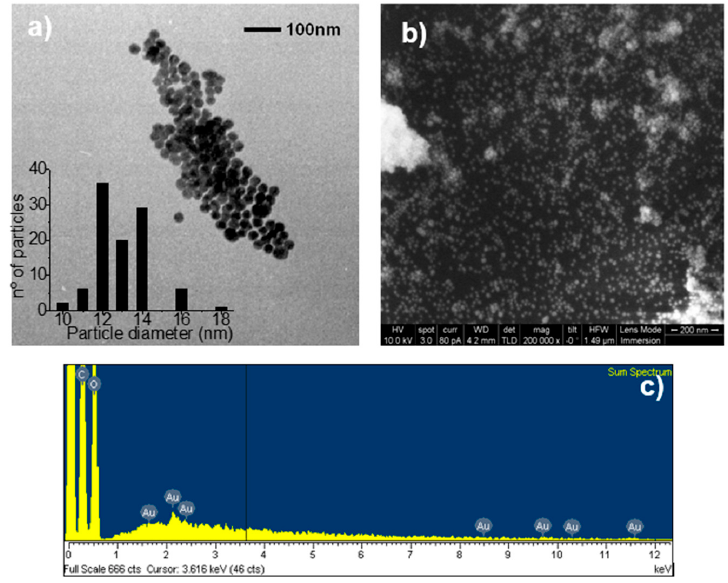
Figure 2. ( a ) TEM micrograph and histogram; ( b ) SEM micrograph; and ( c ) energy-dispersive X-ray spectroscopy (EDS) spectrum of α -CD/OA IC conjugated to AuNPs.